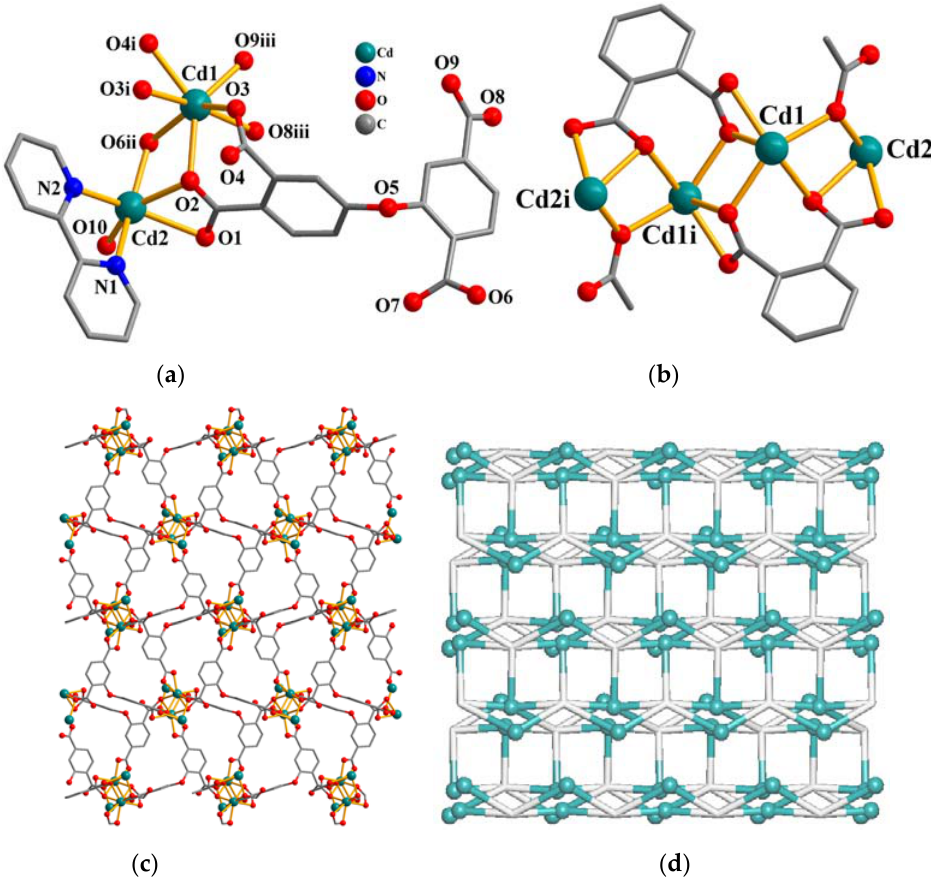
Figure 1. Representations of the structure of 1 . ( a ) Coordination environment and connectivity of cadmium (Cd) atoms. ( b ) A tetracadmium(II) subunit. ( c ) A two-dimensional (2D) coordination polymer structure (view along the a axis). ( d ) Topological view of a simplified 2D net representing a two-nodal 4,6-c layer of the 4,6L45 topological type. View along the a axis; 2-c Cd2 linkers and 4-c Cd1 nodes (balls, turquoise), centroids of 6-c µ 6 -deta 4– nodes (gray sticks).